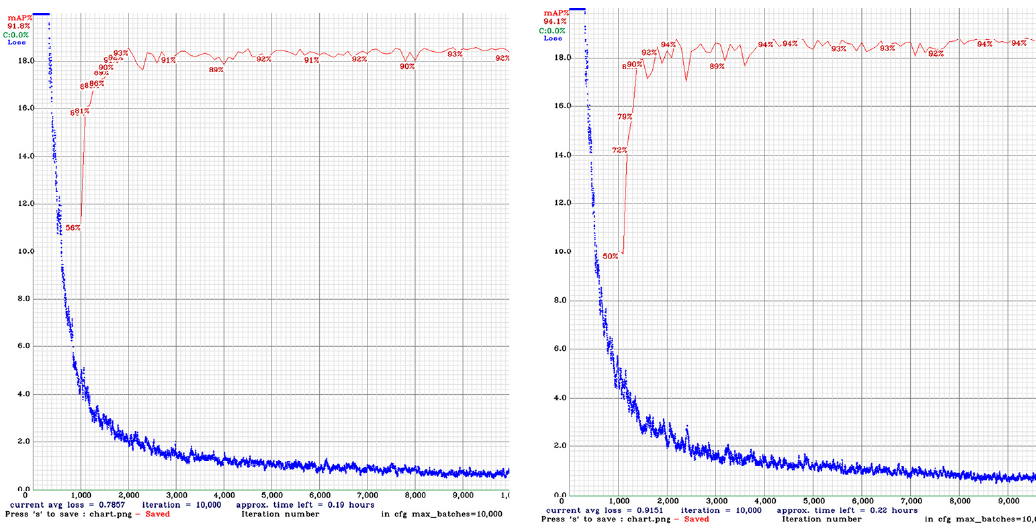
Figure 7. The left side is YOLO v4, the right side is the algorithm of this paper. Figure 7. The ( left ) side is YOLO v4, the ( right ) side is the algorithm of this